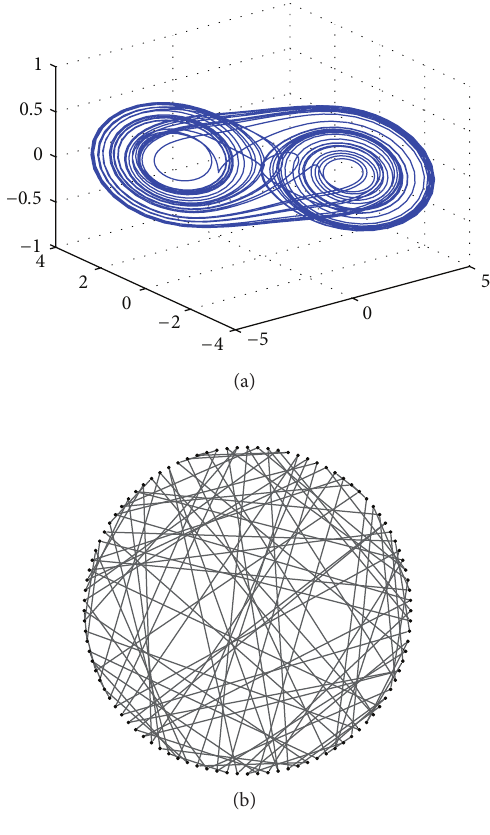
Figure1:PhasetrajectoriesofChua’scircuitwithoutBrowniannoise (a) and the network structure